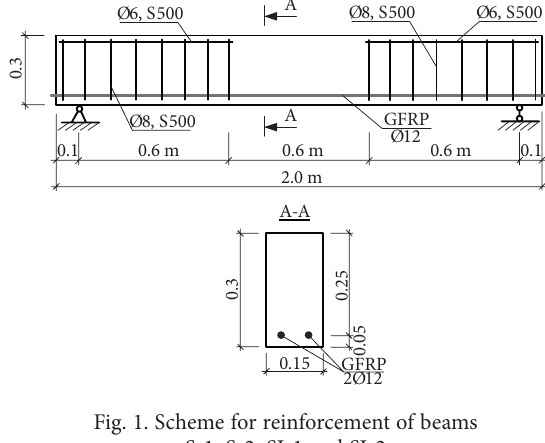
Fig. 1. Scheme for reinforcement of beams